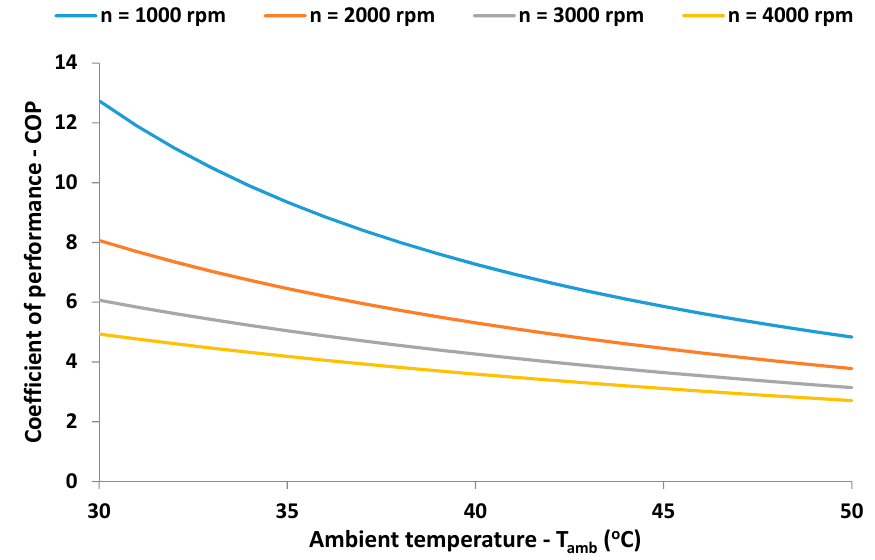
Figure 6. Coefficient of performance for different ambient temperatures and rotational speeds ( T ind = 25 °C).